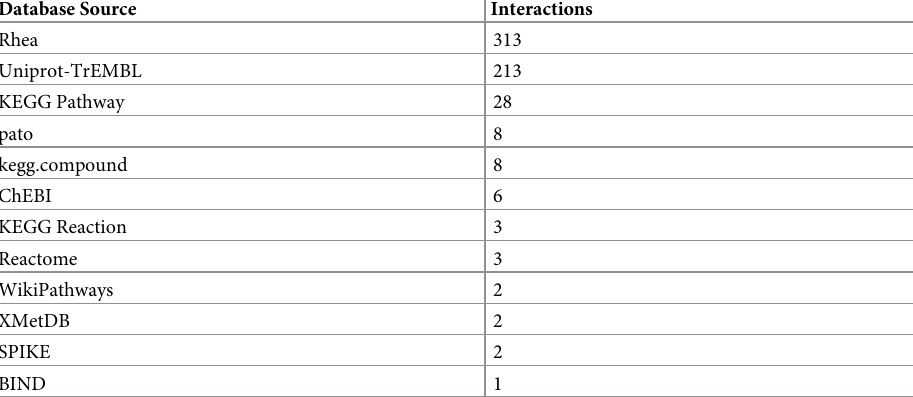
Table 4. Interaction Identifier ID counts by data source. The identifier types for the interactions with a source from the WikiPathways RDF.